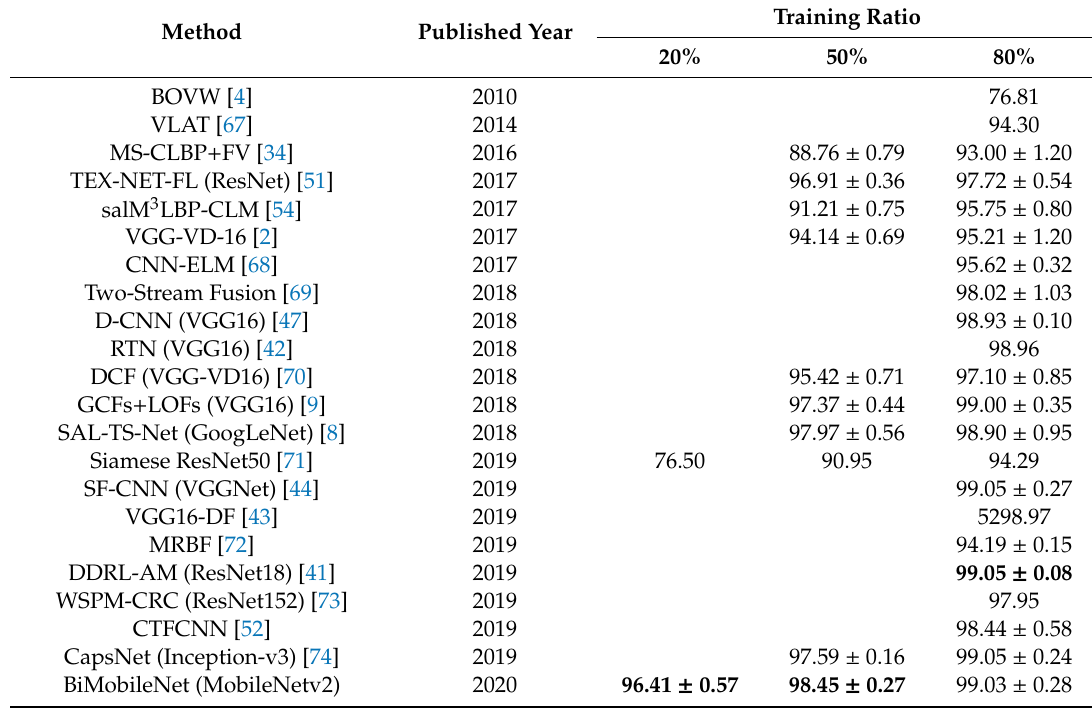
Table 3. Overall accuracy of the state-of-the-art method on UC Merced dataset. The highest accuracy for each ratio is